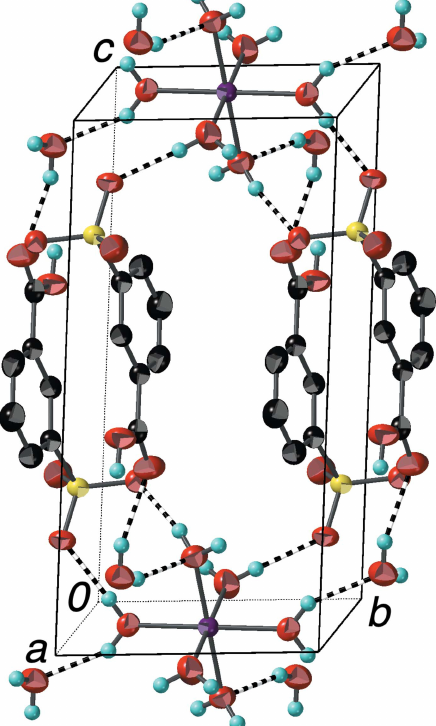
Figure 4 Packing diagram of (II) with the outline of the unit cell showing the alternating layers of hexaaquacobalt(II) cations and 3-carboxybenzene- sulfonate anions. O—H (cid:2)(cid:2)(cid:2) O hydrogen bonds are shown as striped cylinders. H atoms bonded to C atoms have been omitted. Displacement ellipsoids are drawn at the 90% probability